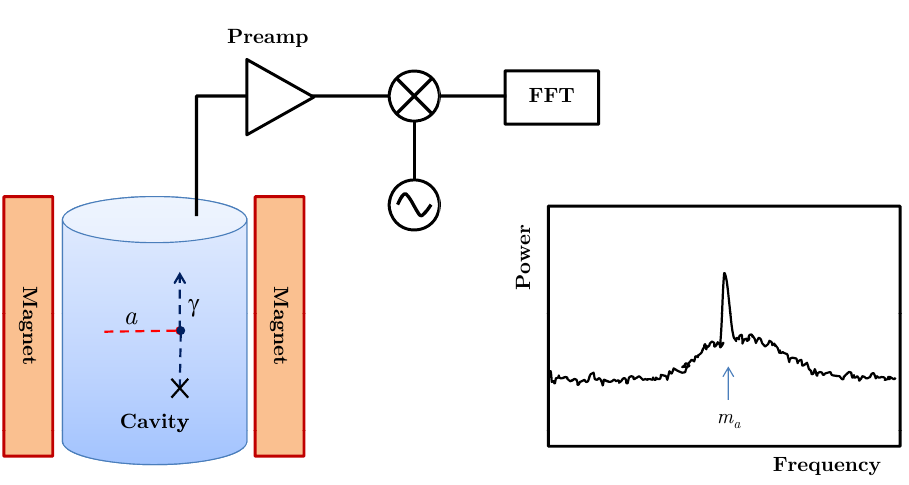
Figure 5: Conceptual arrangement of an axion haloscope. If m resonant frequency of the cavity, the axion will show as a narrow peak in the power spectrum extracted from the